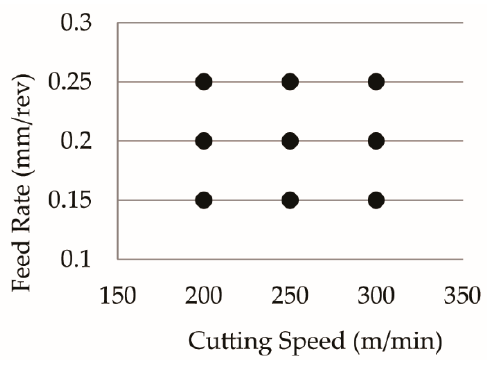
Figure 3. Cutting conditions in the range of cutting parameters.